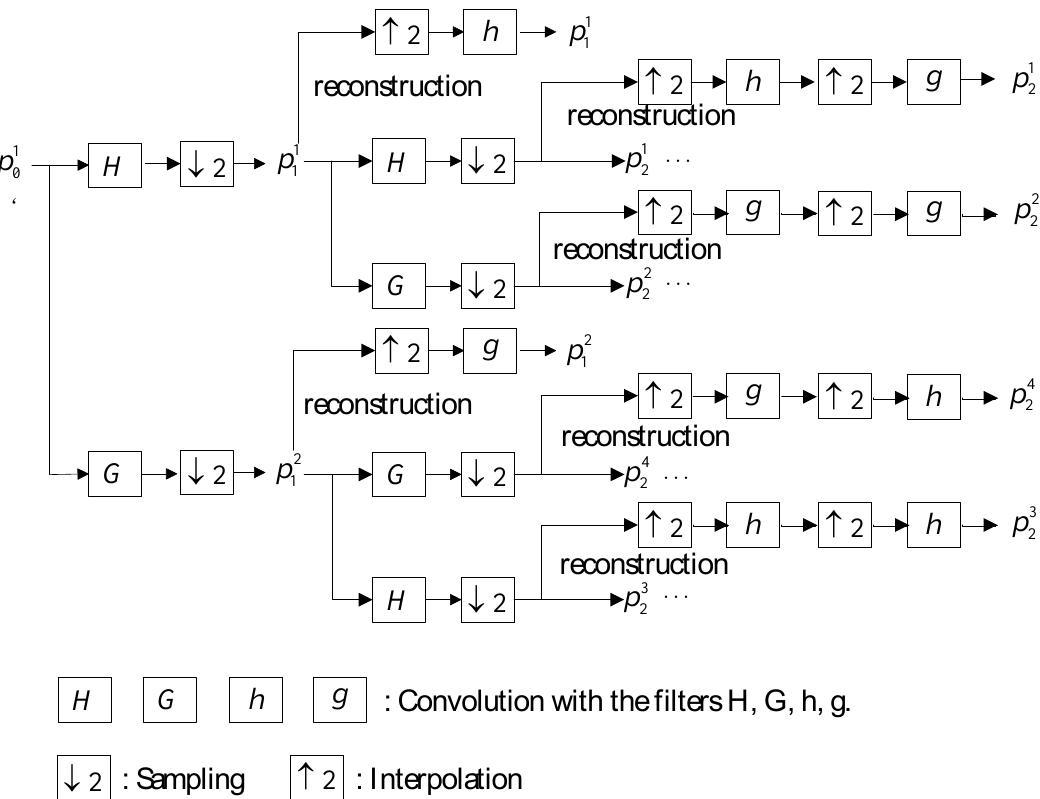
Figure 1. The flow chart of the fast algorithm for binary wavelet packet decomposition.